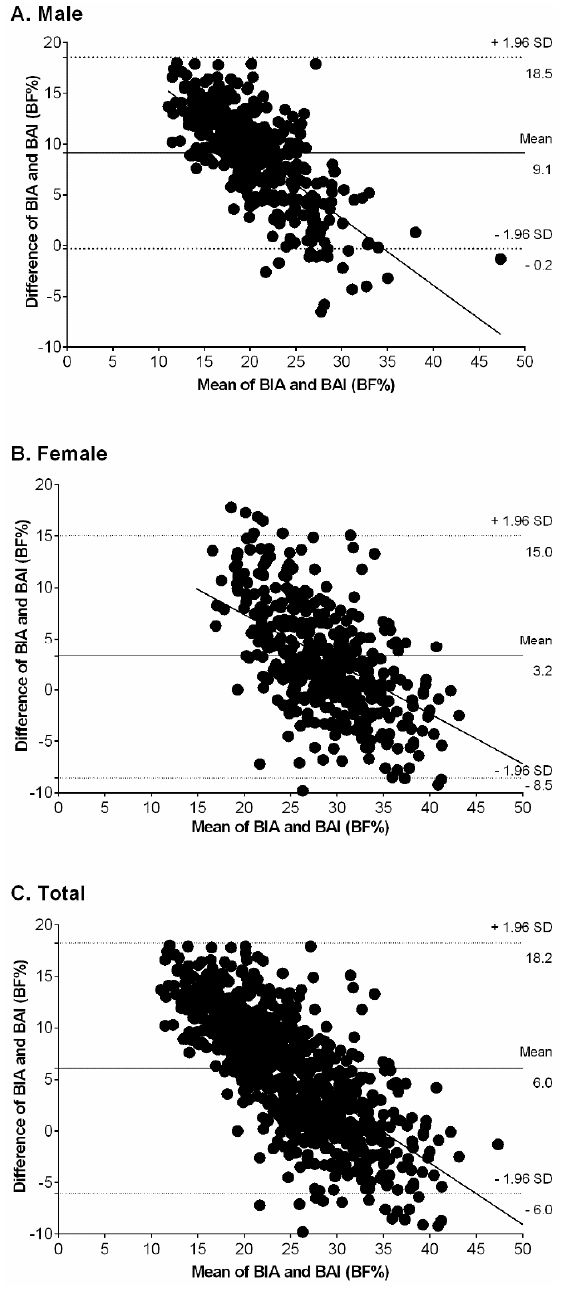
Figure 1. Bland–Altman plots with mean and 95% limits of agreement for comparing BF% BAI and BF% BIA among males ( A ), females ( B ), and total ( C ). The central line represents the mean bias between BF% BAI and BF% BIA ; the outer lines represent 95% limits.